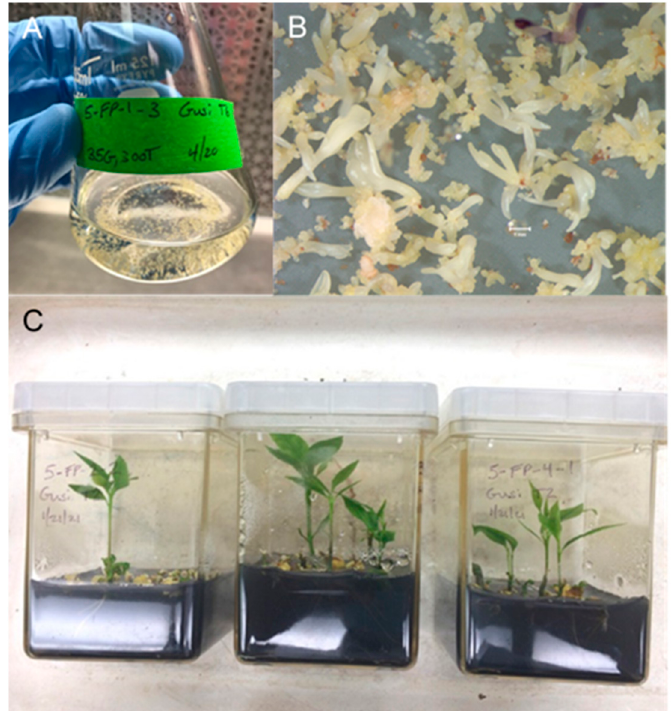
Figure 2 . Production of transgenic ash somatic seedlings. ( A ). Suspension culture of ash PEMs from a single transgenic event, following 6 weeks of growth in liquid medium and size fractionation, just prior to collection on nylon mesh for plating on embryo development medium. ( B ). Transgenic white ash somatic embryos derived from suspension cultures, 5 weeks following fractionation, collection on nylon mesh and plating on embryo development medium. Bar = 1 mm. ( C ). Transgenic green ash somatic seedlings growing in germination medium with activated charcoal.